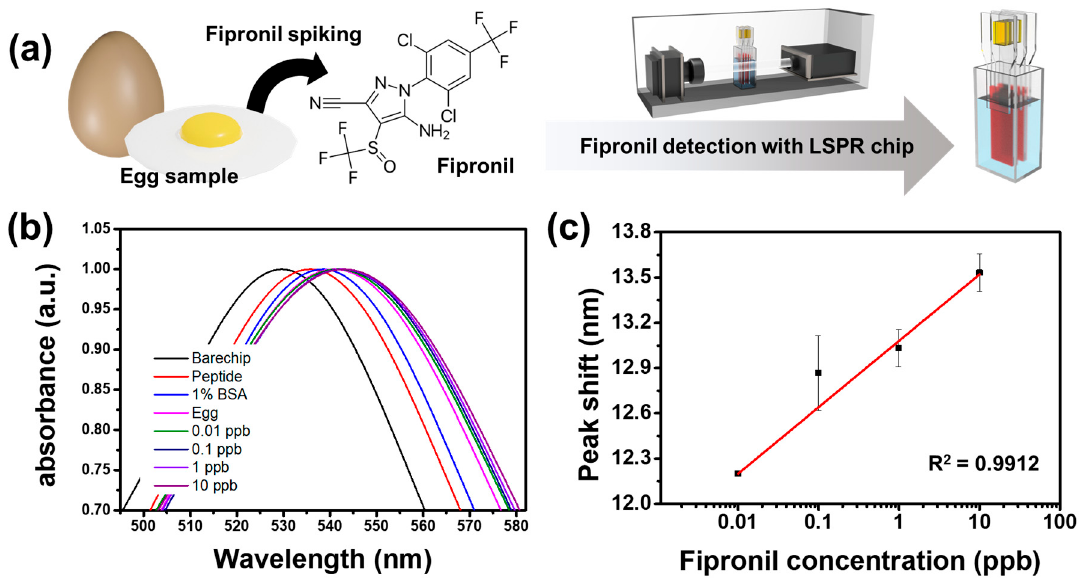
Figure 4. Detection of fipronil-included spiked egg samples using optimized LSPR sensor chips: ( a ) schematic illustration of the experiment, ( b ) sensitivity of LSPR sensor chips under various concentrations of spike samples, and ( c ) changes in the spectrum peak at different concentrations of spike samples reacted on the chip.